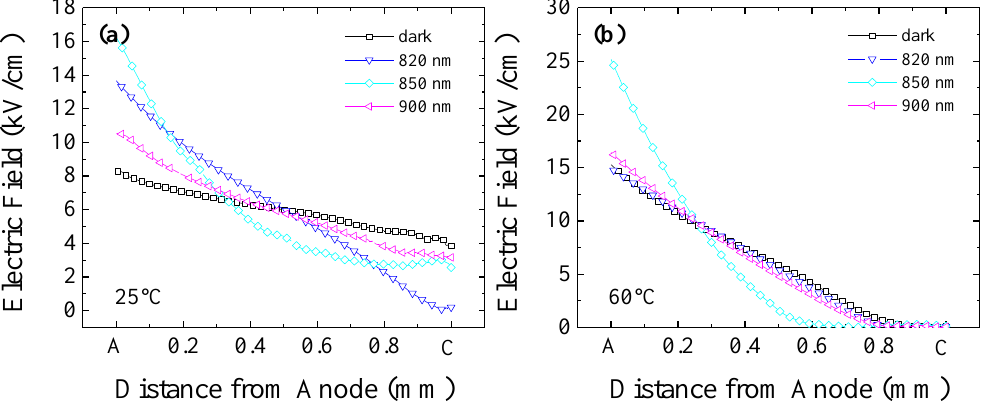
Figure 6. Electric field profiles at T = 25 °C ( a ), and T = 60 °C ( b ) under different optical irradiation conditions on the cathode side: 820 nm, 850 nm, 900 nm. For comparison, the profile corresponding to no optical irradiation is also reported. Bias is 600 V.